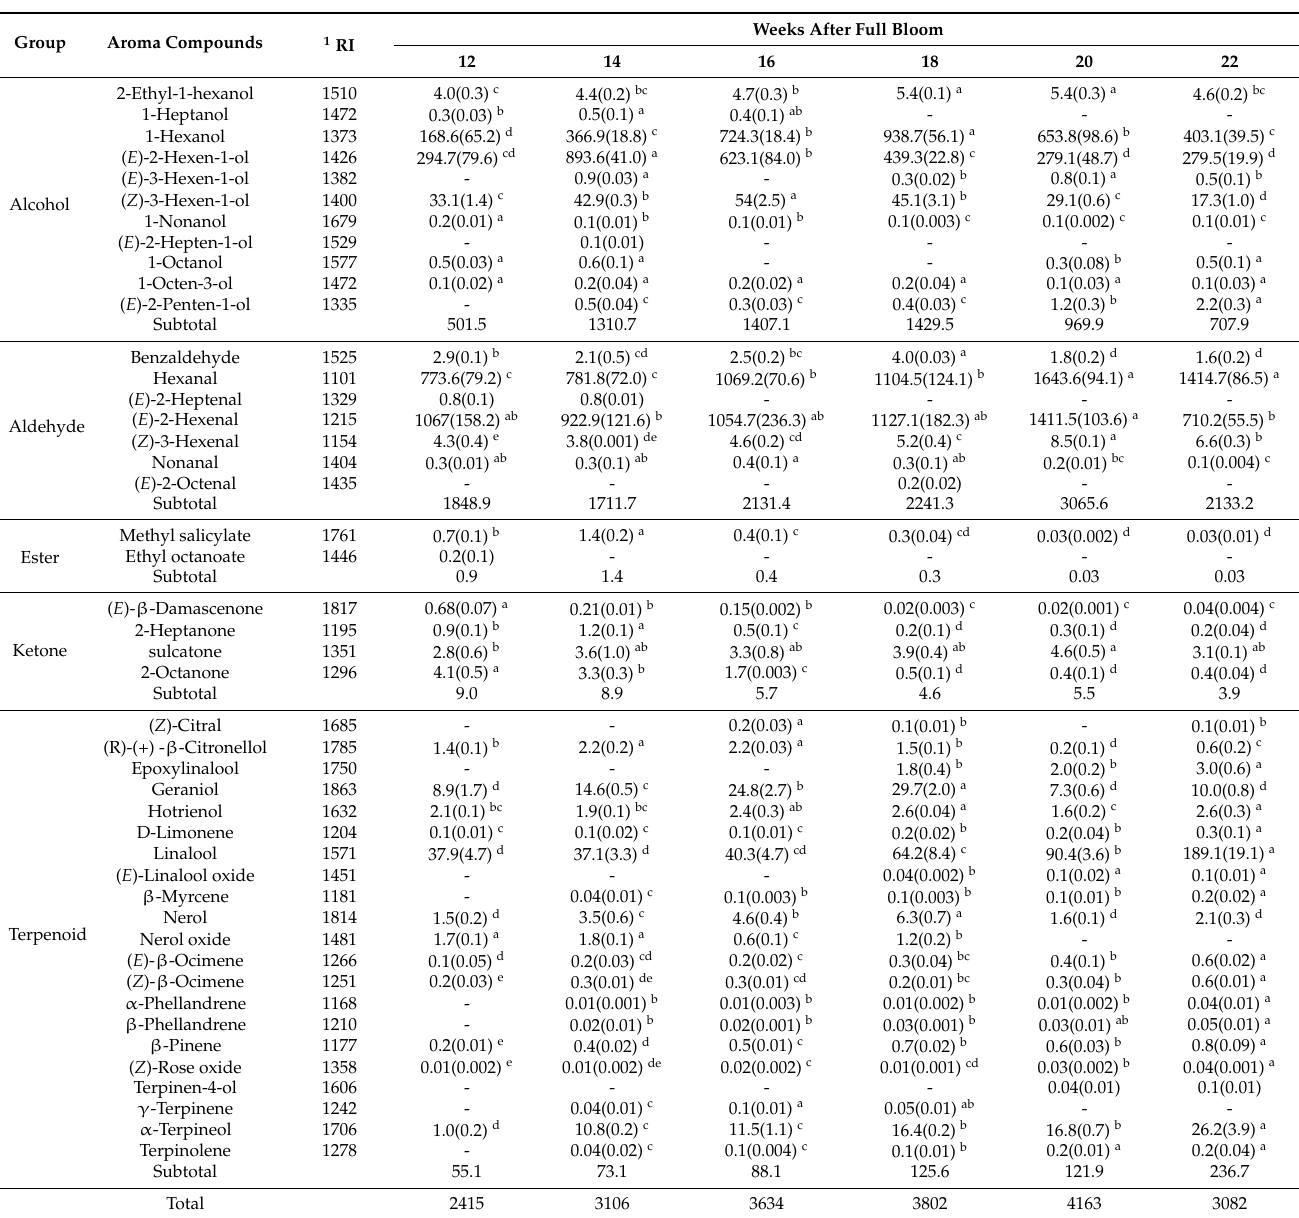
Table 2. Changes in composition and concentration of free volatile aroma compounds in Shine Muscat grapes during